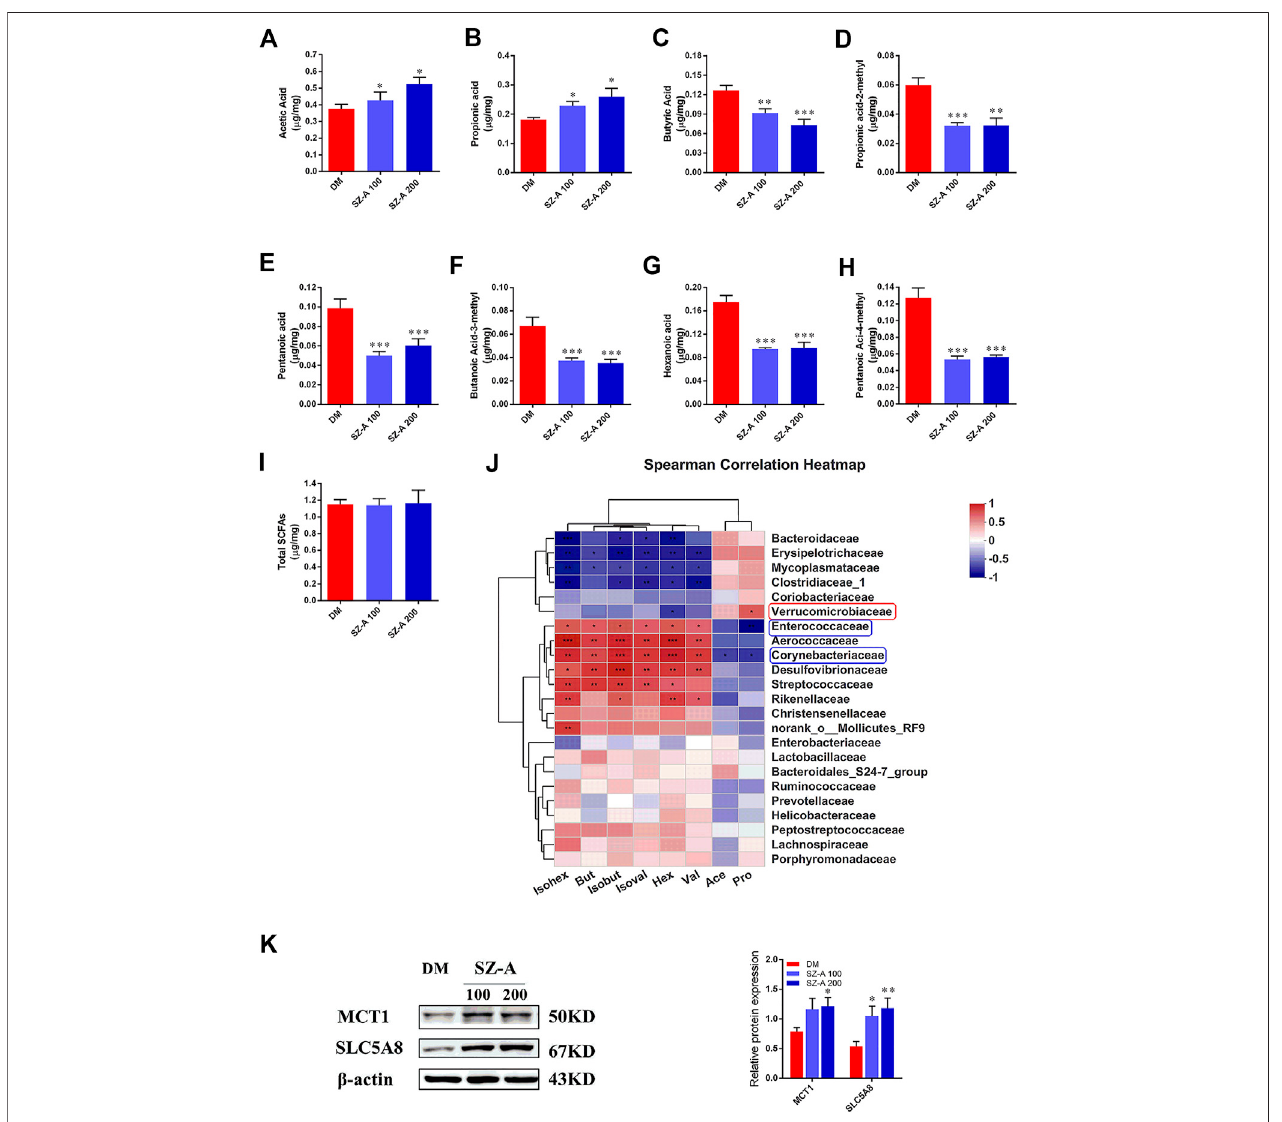
FIGURE3| SZ-Aalters SCFAcompositionoffecalsamplesinKKAymice.FecalSCFAconcentration,including (A) acetic acid, (B) propionicacid, (C) butyricacid, (D) propionicacid-2-methyl, (E) pentanoic acid, (F) butanoic-acid-3-methyl, (G) hexanoic acid, (H) pentanoic-acid-4-methyl and (I) totalSCFAs. (J) Correlationanalysis of SCFAs and speci fi c microbiota at the family level. The p values are shown in different colors in the diagram. The blue represents negative correlation, and red represents positive correlation. n (cid:1) 7 – 8. (K) MCT1 and SLC5A8 protein abundance in the ileum tissue. The blots shown are representative images. n (cid:1) 6. Data are mean ± SEM,* p < 0.05,** p < 0.01,*** p < 0.001 vs